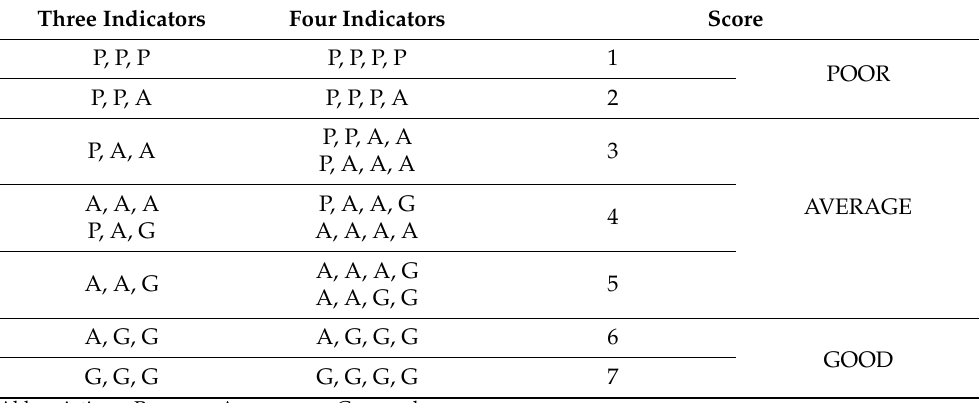
Table 3. The way to determine the assessment of each dimension